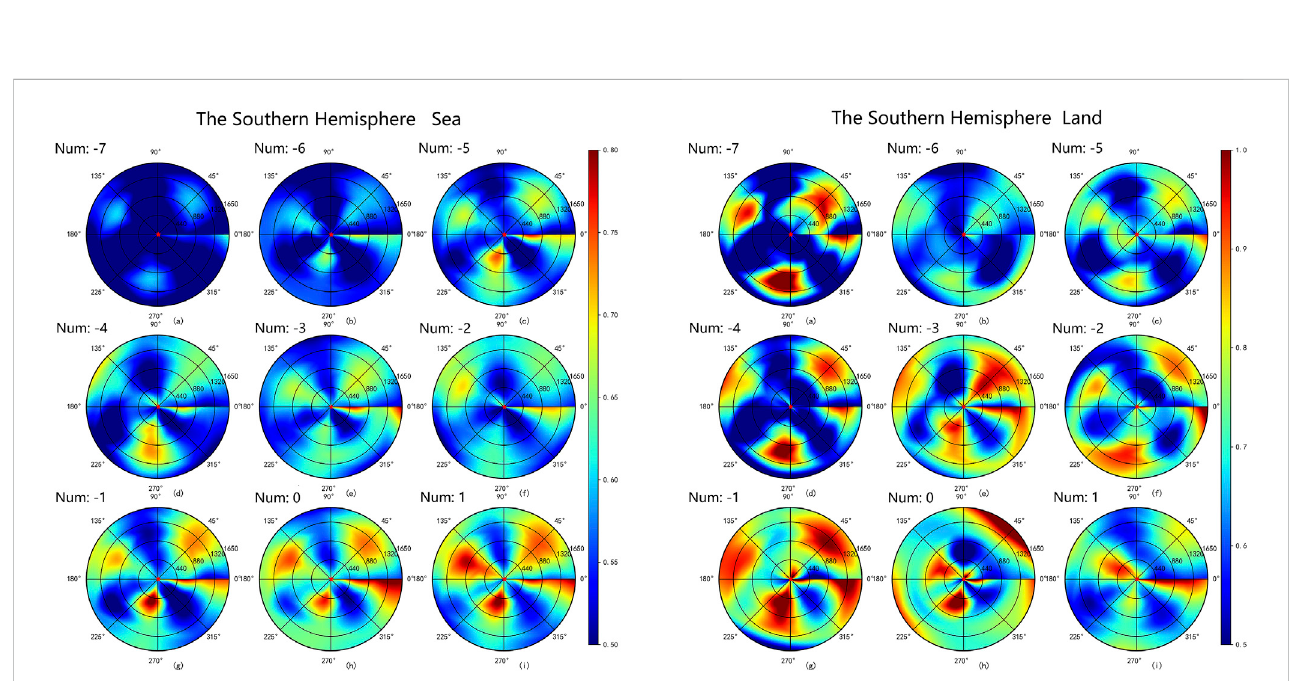
FIGURE 7 Spatial and temporal distribution of spatial electric fi eld ELF band (19.5 – 250 Hz) perturbations in sea and land earthquakes above magnitude 6.0 in the Southern Hemisphere. (Num: − 7 to Num: − 1 represents the seventh cycle to the fi rst cycle before the earthquake, Num: 0 is the period of earthquake, Num: 0 is the fi rst period after the